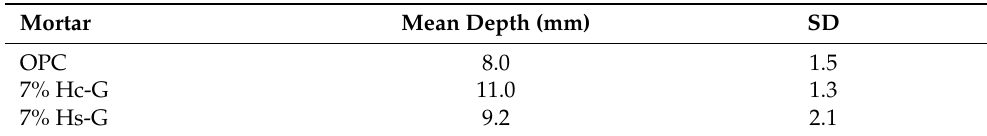
Table 5. Mean carbonation depth and standard deviation